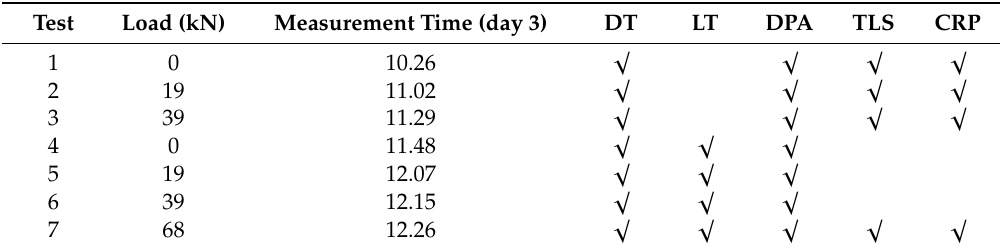
Table 3. Plan of the performed measurements